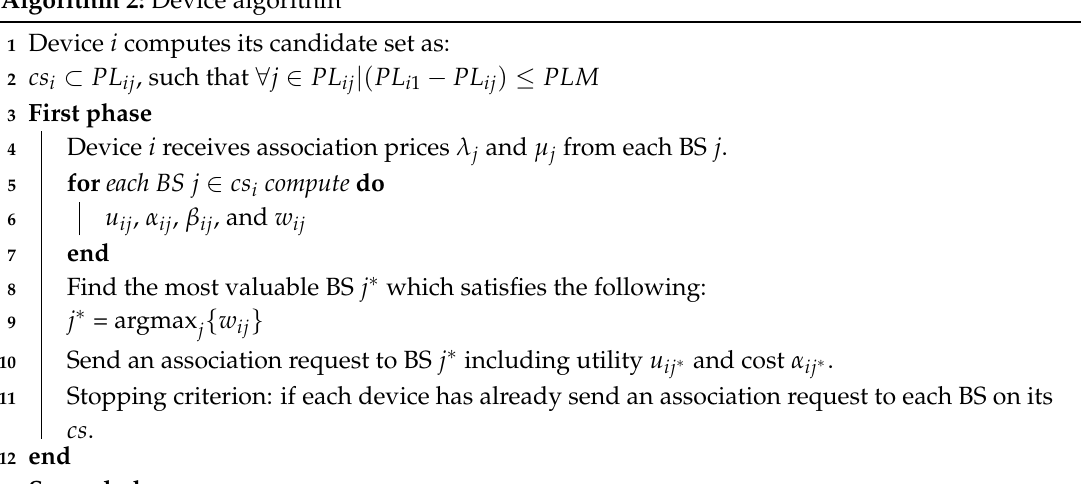
Algorithm 2: Device